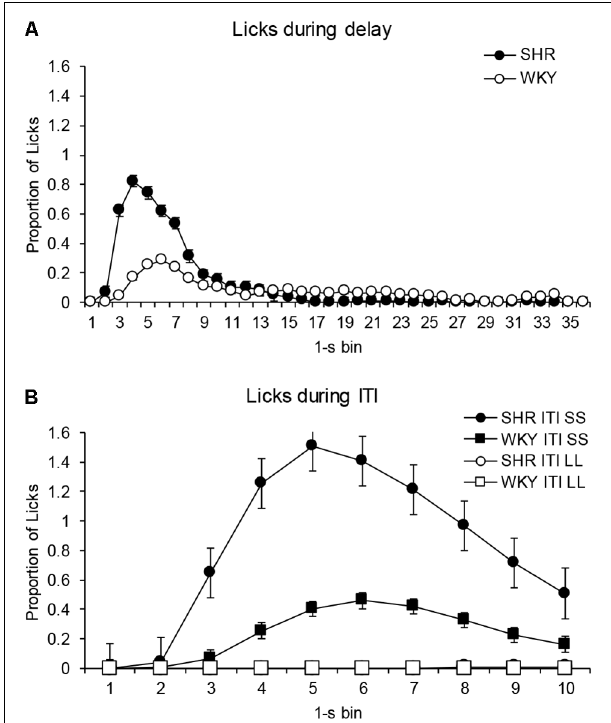
FIGURE 5 | Proportion of licks for each of the 1-s bins that comprised the time intervals of the delay-discounting procedure. (A) Proportion of licks during the delay. Black circles depict data from SHR rats and white circles from WKY rats. (B) Proportion of licks during ITI. Black symbols depict data from licks given during the ITI after choosing the SS alternative, and white symbols data from the ITI after choosing the LL alternative. Circles represent data from SHR and squares from WKY. Vertical bars denote standard error of the